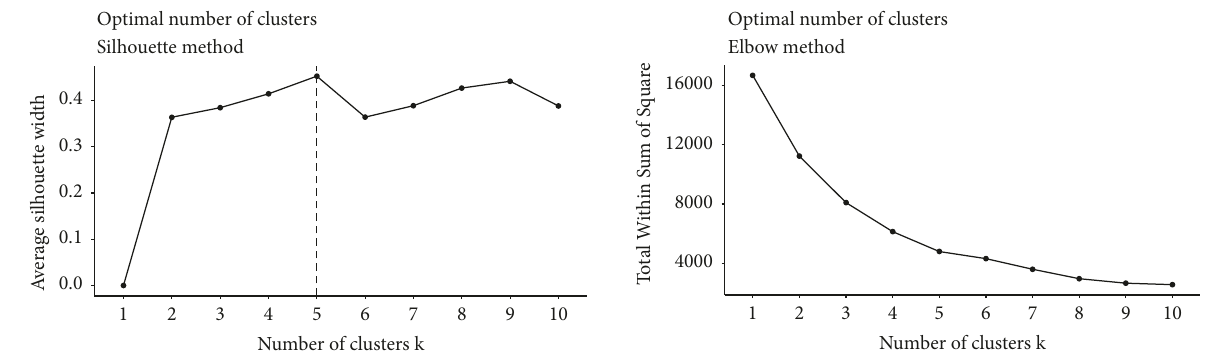
Figure 1: Identifying the best number of clusters: Silhouette method on the left and Elbow method on the